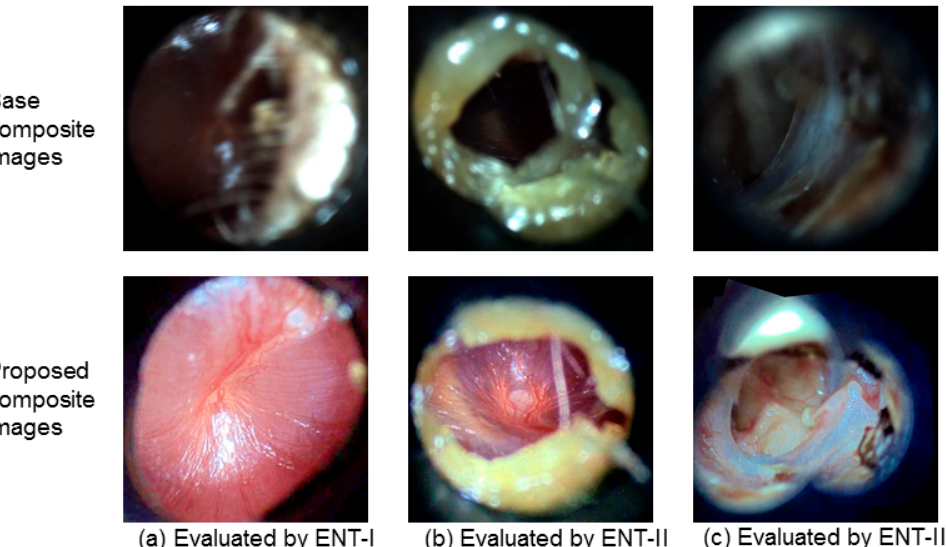
Figure 7. Examples of successful composite results using our approach. The first row shows the images generated by the base processes and the second row shows the images by our approach, SelectStitch. Each column indicates the number of readers. Each reader gives the score of 1 for the base image and 3 for the proposed image.